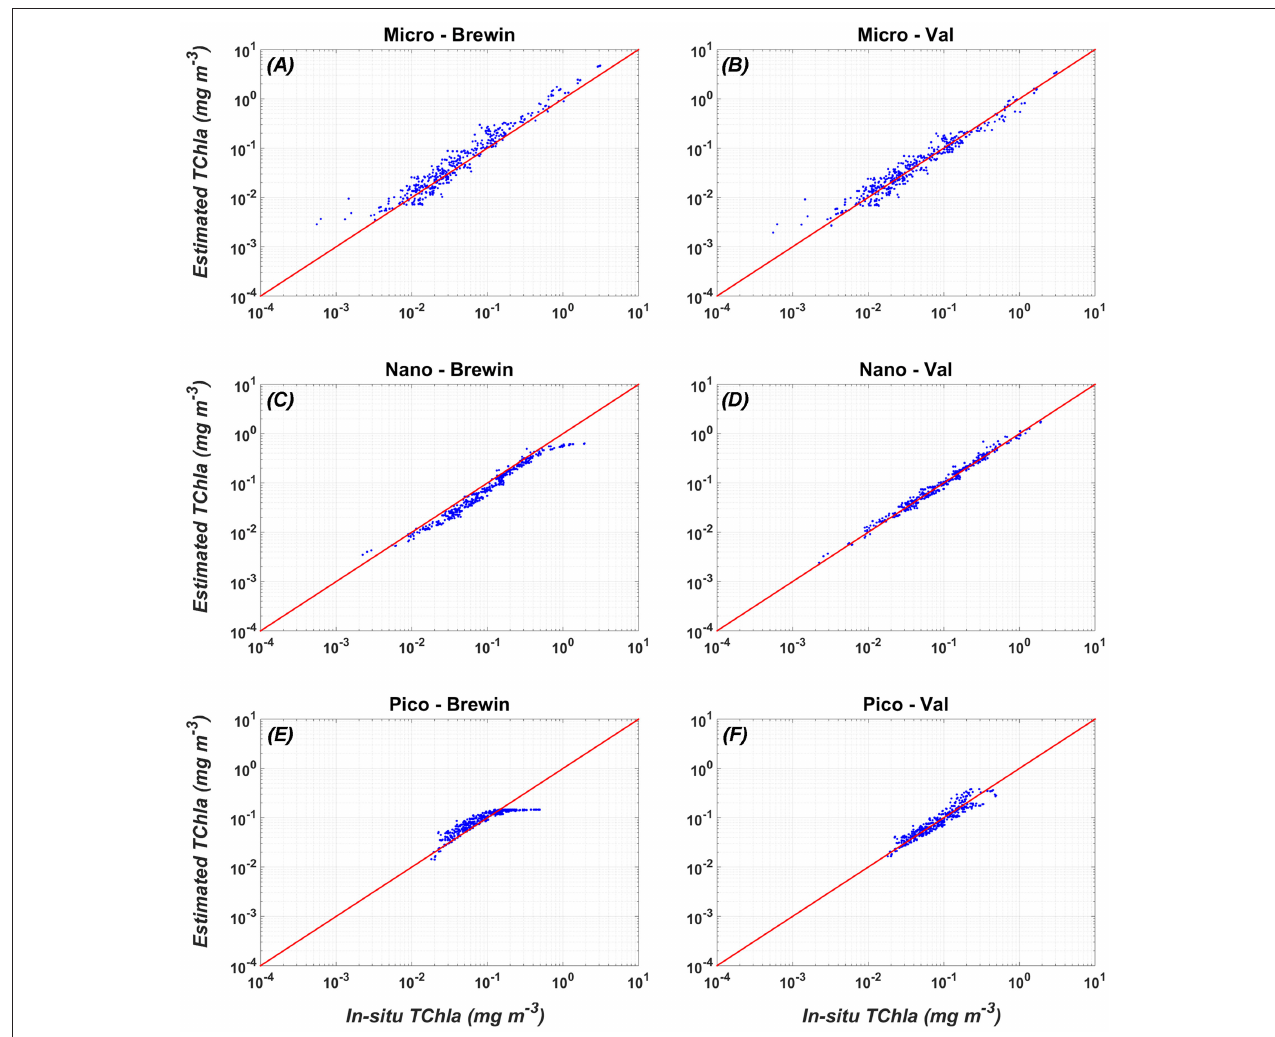
FIGURE 3 | Comparison between the validation ( in-situ vs. estimated PSC TChl a concentrations) of the new PSC regional algorithms (Val, right panel: B,D,F) vs. the global PSCs model of Brewin et al. (2011) (Brewin, left panel: A,C,E ). For the statistics, see Table 7 .